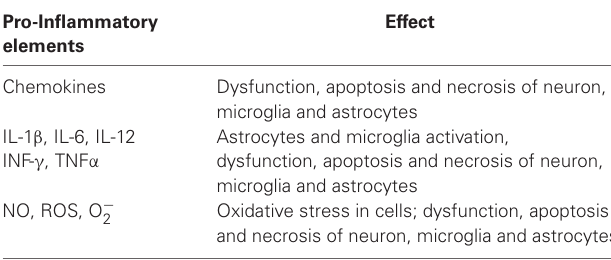
Table 1 | Pro-inflammatory elements secreted by astrocytes and microglia during the process of neuroinflammation.